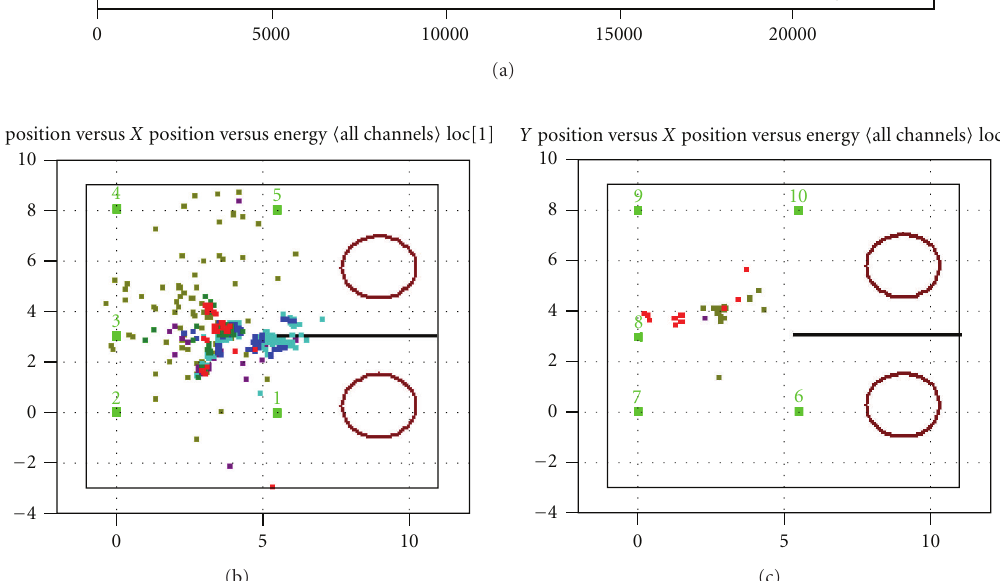
were designed and fabricated to mount the CT